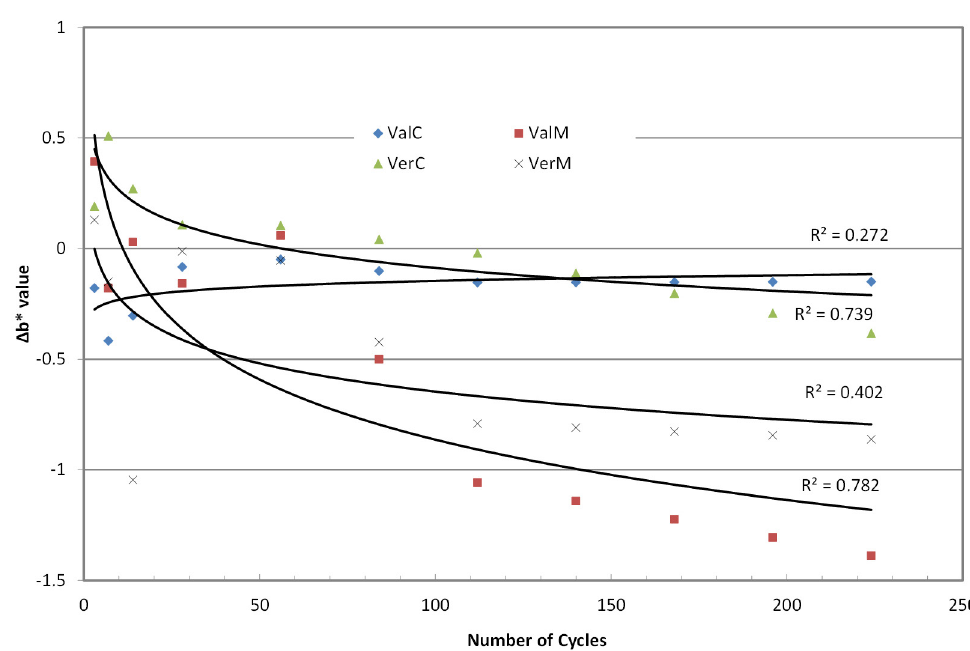
Figure 5- Trend lines for changes in Δa* values